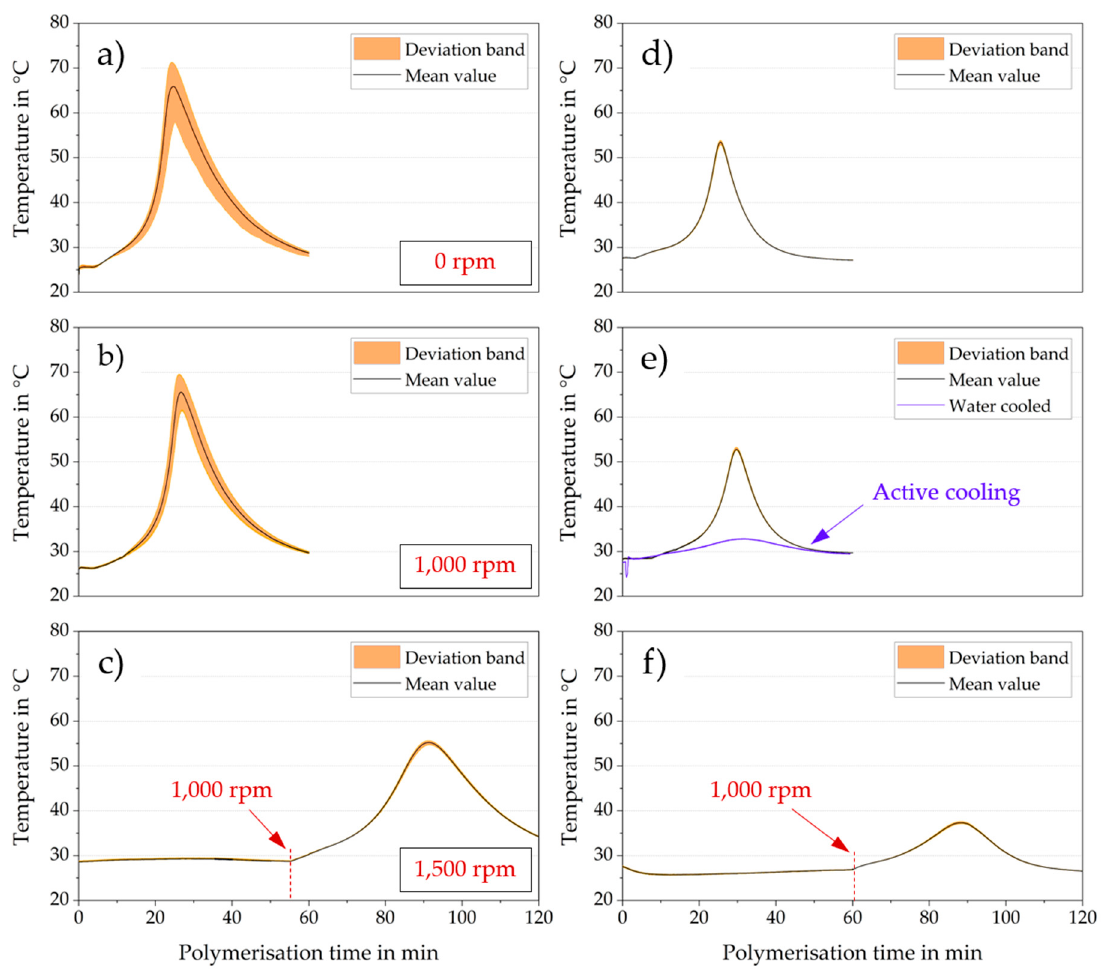
Figure 4. Temperature records inside a PBM solution subjected to redox polymerization (10 g for ( a ), ( b ), ( c ) and 1.5 g for ( d ), ( e ), ( f ) test volume). Complete polymerization at high turbulences (1500 rpm) did not occur for either PBM Much higher temperature deviations in the space (yellow area) for the stagnant PBM solution (max. ± 14.5 K) indicated a highly inhomogeneous polymerization, whereas the temperature distribution was reduced at 1000 rpm (max. ± 6.5 K).